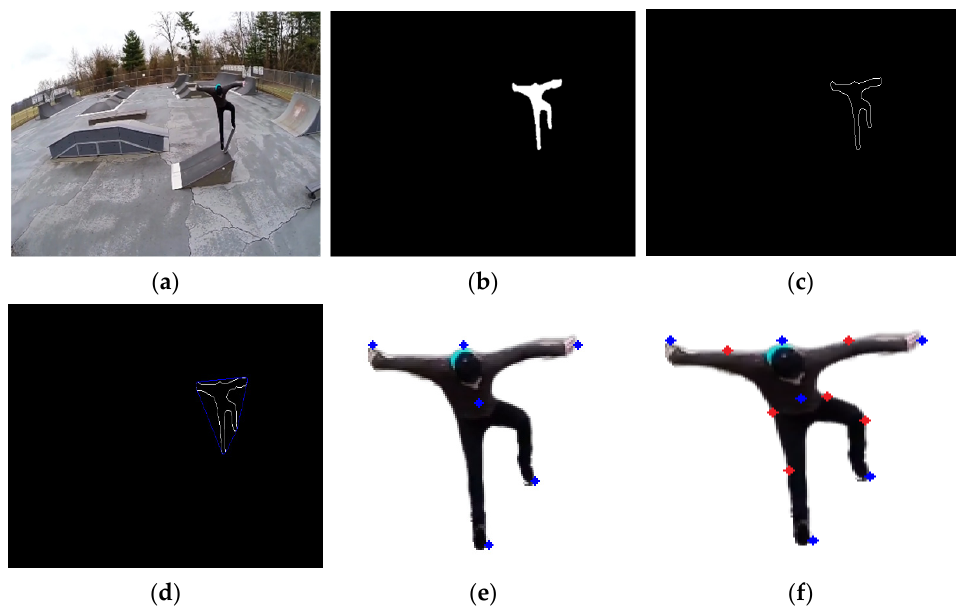
Figure 4. Steps of human body points detection over the YouTube Aerial dataset, including ( a ) orig- inal image, ( b ) binary silhouette, ( c ) silhouette contour, ( d ) convex hull, ( e ) six key points, and ( f ) twelve key points.